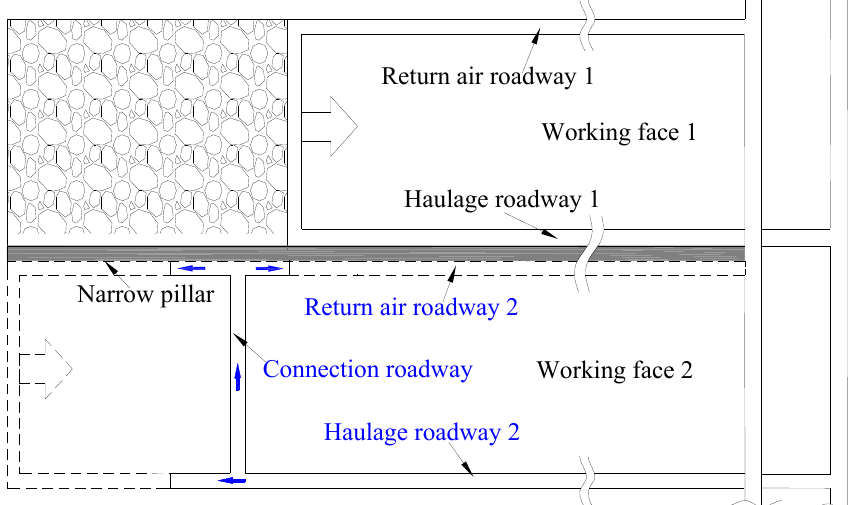
Figure 23. Layout method of the “H” type for mining roadways in longwall coal faces. The blue